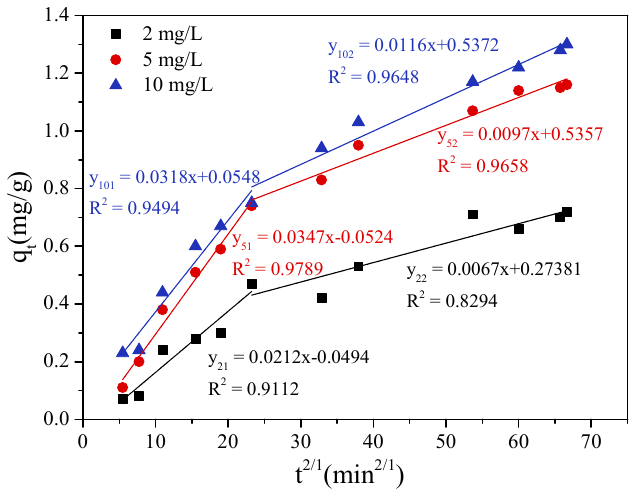
Figure 12. Fitting of the fluoride adsorption process with the Weber and Morris model.